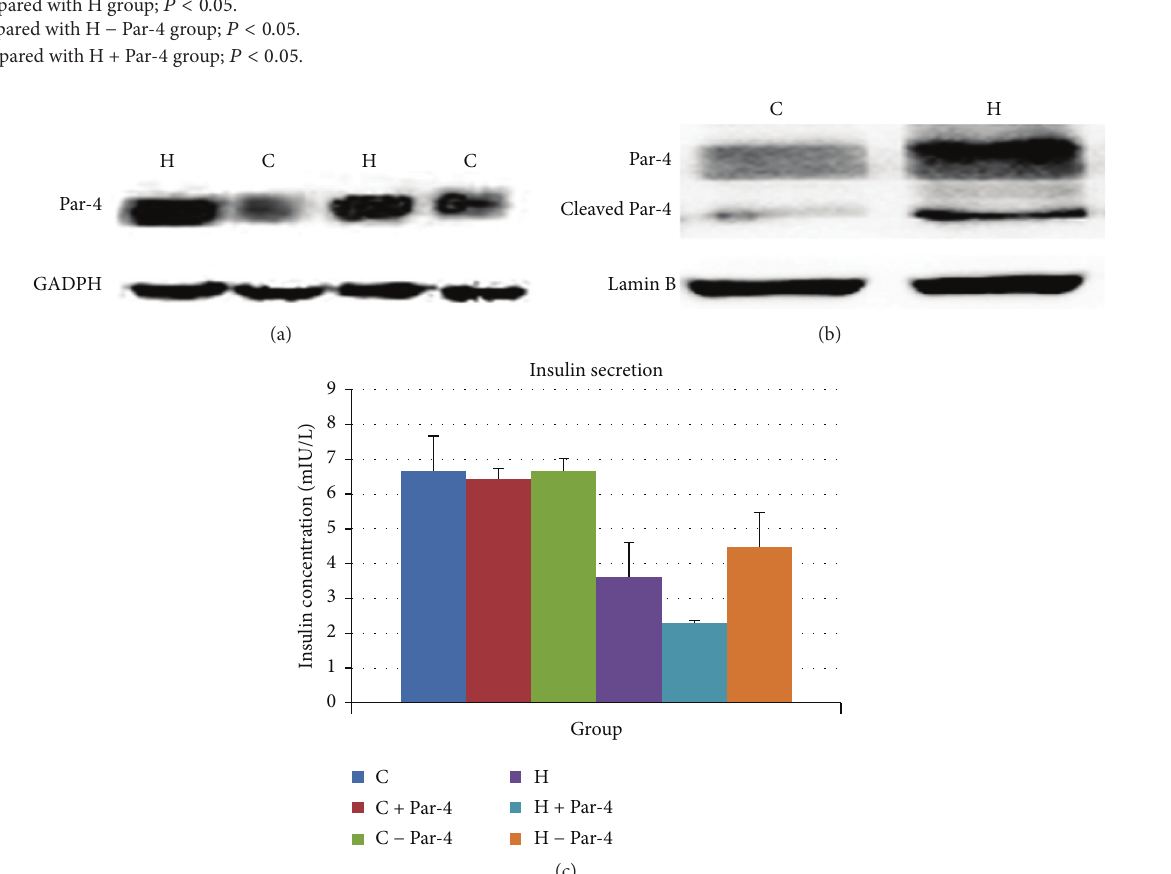
Figure 1: Par-4 is upregulated and secreted after glucose and palmitate cointervention in